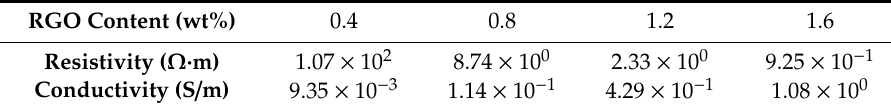
Table 1. The resistivity and conductivity of the